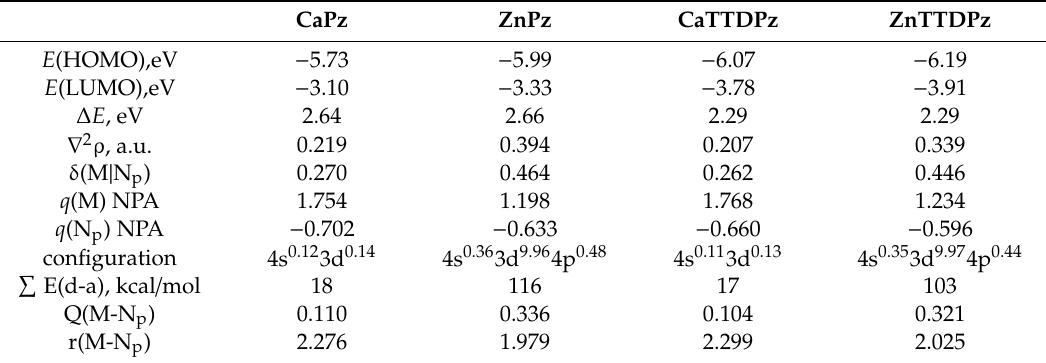
Table 2. Selected parameters of MPz and MTTDPz complexes from NBO and quantum theory of atoms in molecules (QTAIM) calculations.